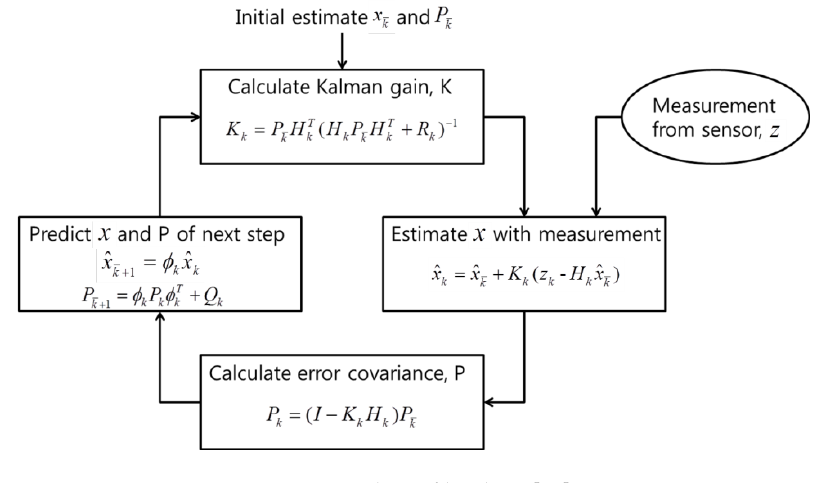
Figure 3. Kalman filter loop [12] .